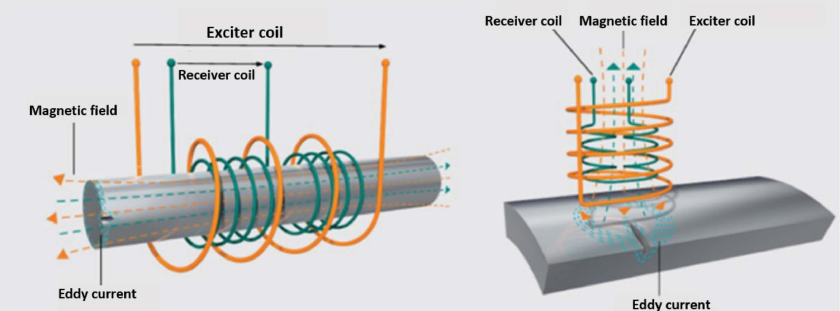
Figure 8. Example of the eddy current method for detection of flaws on a steel pipe [22]. The signals from the eddy current method can be affected and distorted by factors such as lift-off (distance between the test coil and the specimen), electrical conductivity, magnetic permeability, inhomogeneity of the material, or the thickness of the test piece [23]. Lift-off is one of the most common problems for EC tests, slowing down and limiting the growth of its applications. Further factors that can affect the received signals are the noise and low-level signals [24,25]. To provide for the desired parameters and accurate readings, signal processing, signal analysis, and feature extraction and classification of the model must be performed.